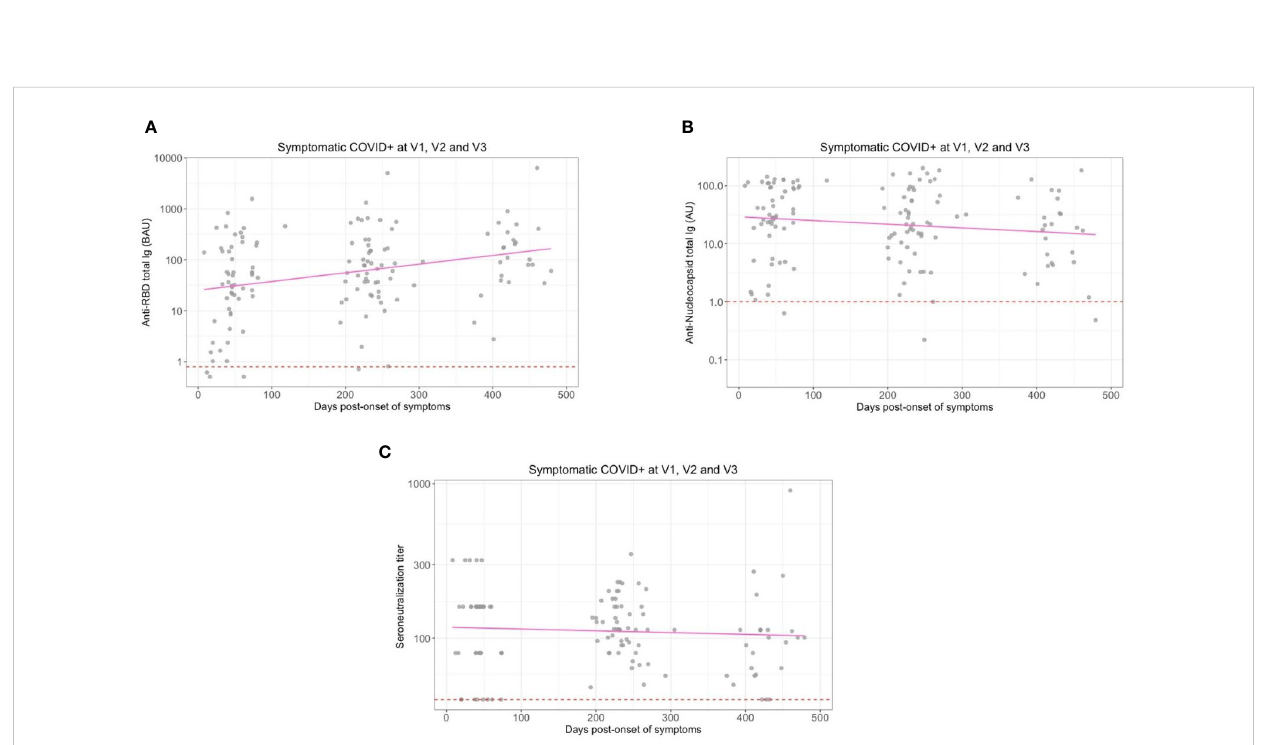
FIGURE 2 Serum anti-SARS-CoV-2 total Immunoglobulins (Ig) and seroneutralization titers at each visit and without immunization for previously infected individuals. (A) Titers of total Ig targeting the Spike/RBD and (B) the Nucleocapsid in serum from previously infected individuals are represented at enrollment (V1), 6 months (V2) and 12 months (V3) later. (C) Seroneutralization titers from previously infected individuals at V1, V2 and V3. The positivity thresholds are represented with a red dashed line. Linear regression slopes from (A, B) were signi fi cantly different from zero with p < 0.001.